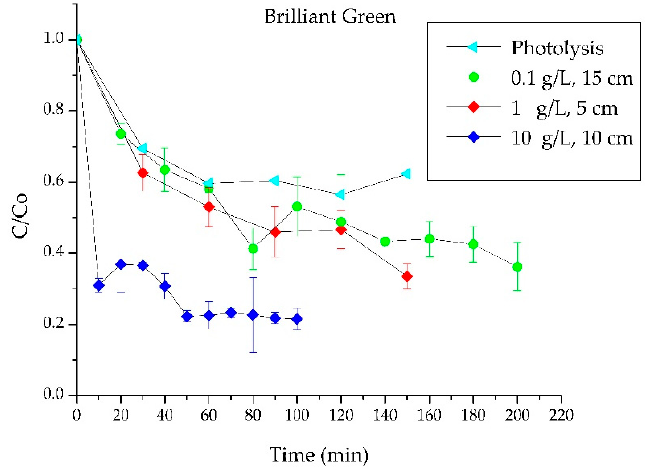
Figure 10. Degradation curves of Brilliant Green for different amounts of catalyst and irradiation time, under visible light irradiation. Photolysis of the pollutant is also included.